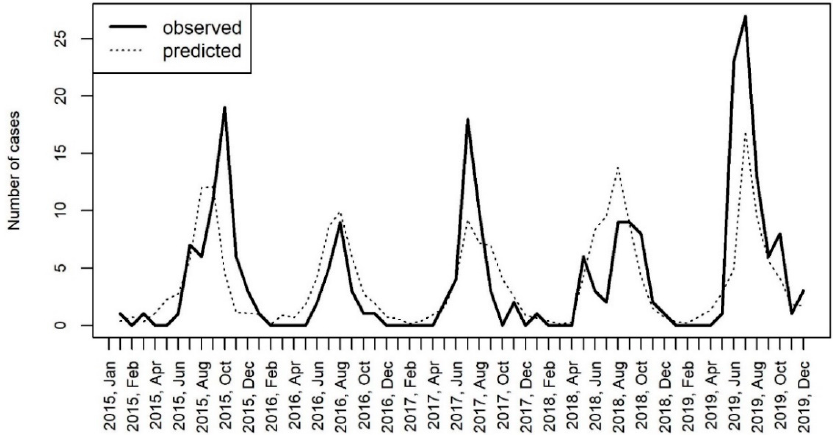
Figure 7. The comparison of hospitalizations for CNS infections caused by enteroviruses in Bialystok, Poland with the number of cases predicted by the generalized linear mixed effects model (GLMM) including the temperature and the precipitation as covariates.